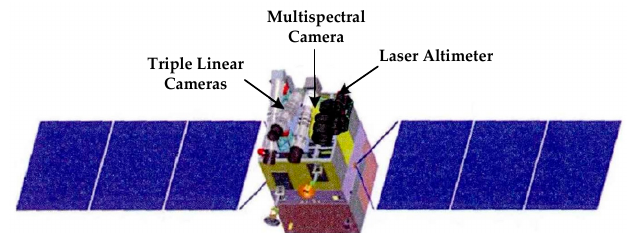
Figure 1. Schematic diagram of the installation of the laser altimeter and the triple linear array cameras (TLCs) onboard the ZY3-02 satellite.